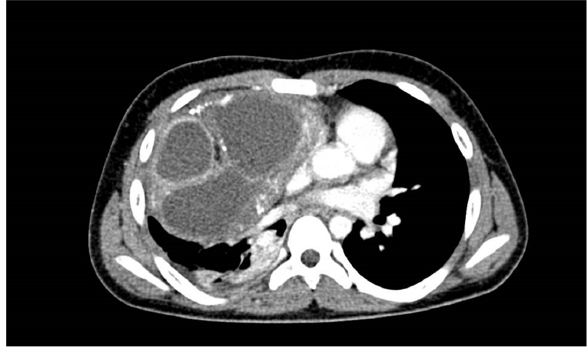
Figure 8. Transverse CT scan of the chest.